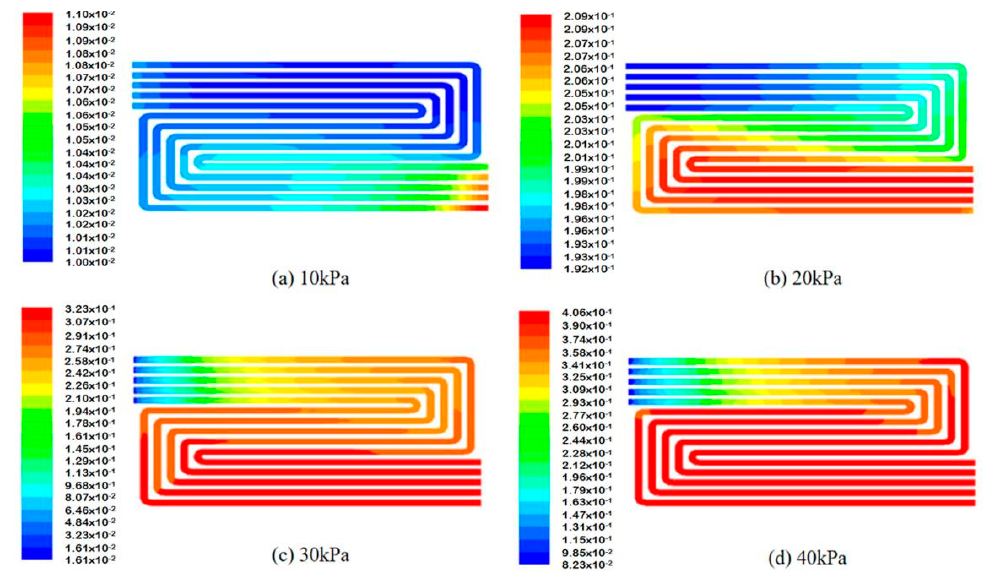
Figure 4. Water content in the anode channel under different inlet pressures: ( a ) 10 kPa, ( b ) 20 kPa, ( c ) 30 kPa, ( d ) 40 kPa.